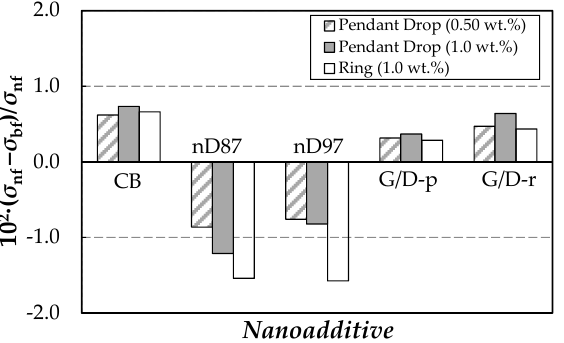
Figure 10. Average modifications in surface tension regarding pure PEG400, 10 2 ·( σ nf − σ bf )/ σ nf , obtained for the 0.50 and 1.0 wt.% nanofluids using the pendant drop method and for 1.0 wt.% nanofluids using the ring method.